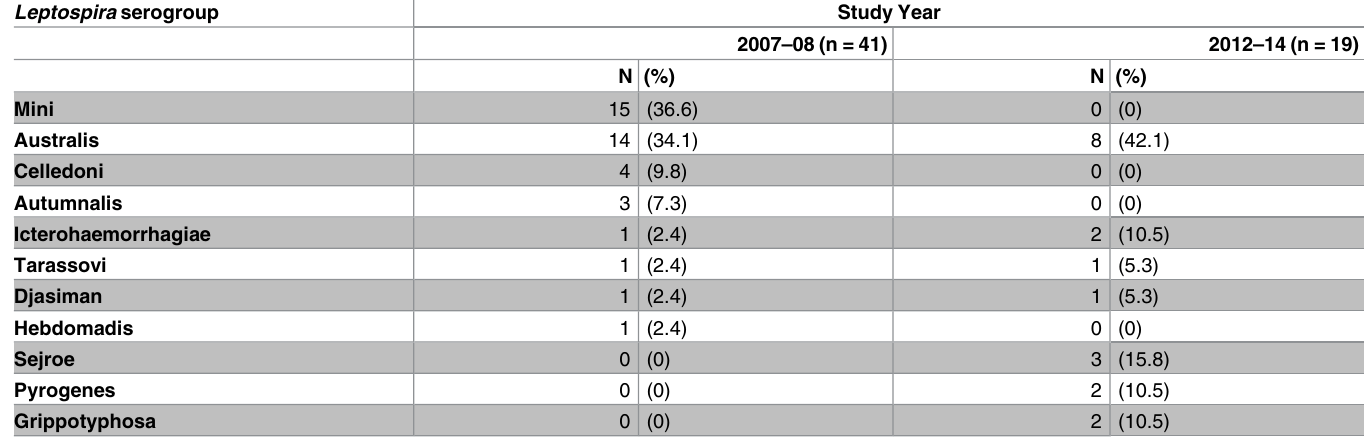
Table 3. Frequency of confirmed and probable acute leptospirosis defined by predominant reactive Leptospira serogroup, Moshi Rural and Moshi Rural Districts, Tanzania, 2007–8and 2012–14. Leptospira